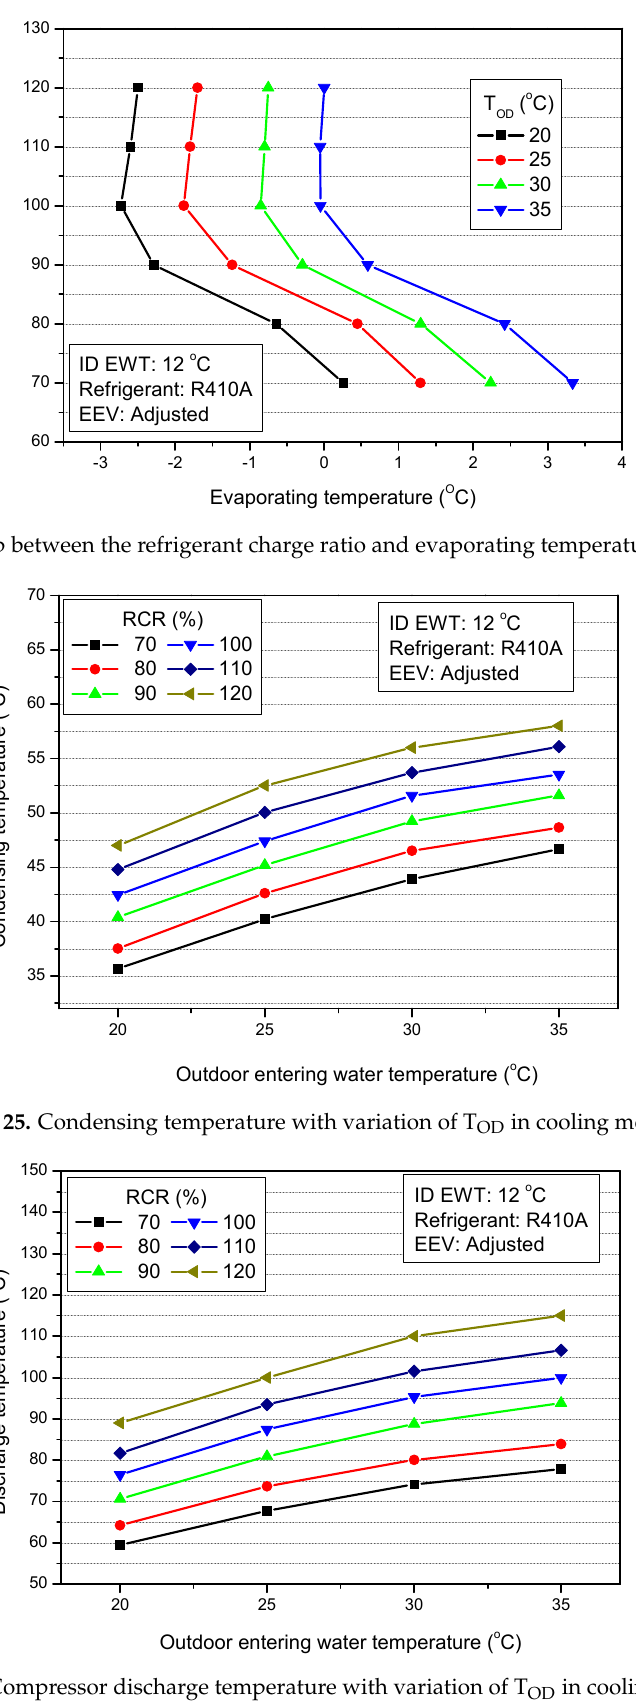
Figure 26. Compressor discharge temperature with variation of T OD in cooling mode. In heating mode, the relationship between the refrigerant charge ratio and condensing temperature, degree of subcooling and evaporating temperature were modelled as 2nd order polynomials according Figures 27–29 respectively. The relationship between RCR and the compressor discharge temperature was modelled as a 3rd order polynomial according to Figure 30. 40 Condensing temperature ( o C) Figure 27. Relationship between refrigerant charge ratio and condensing temperature in heating mode.